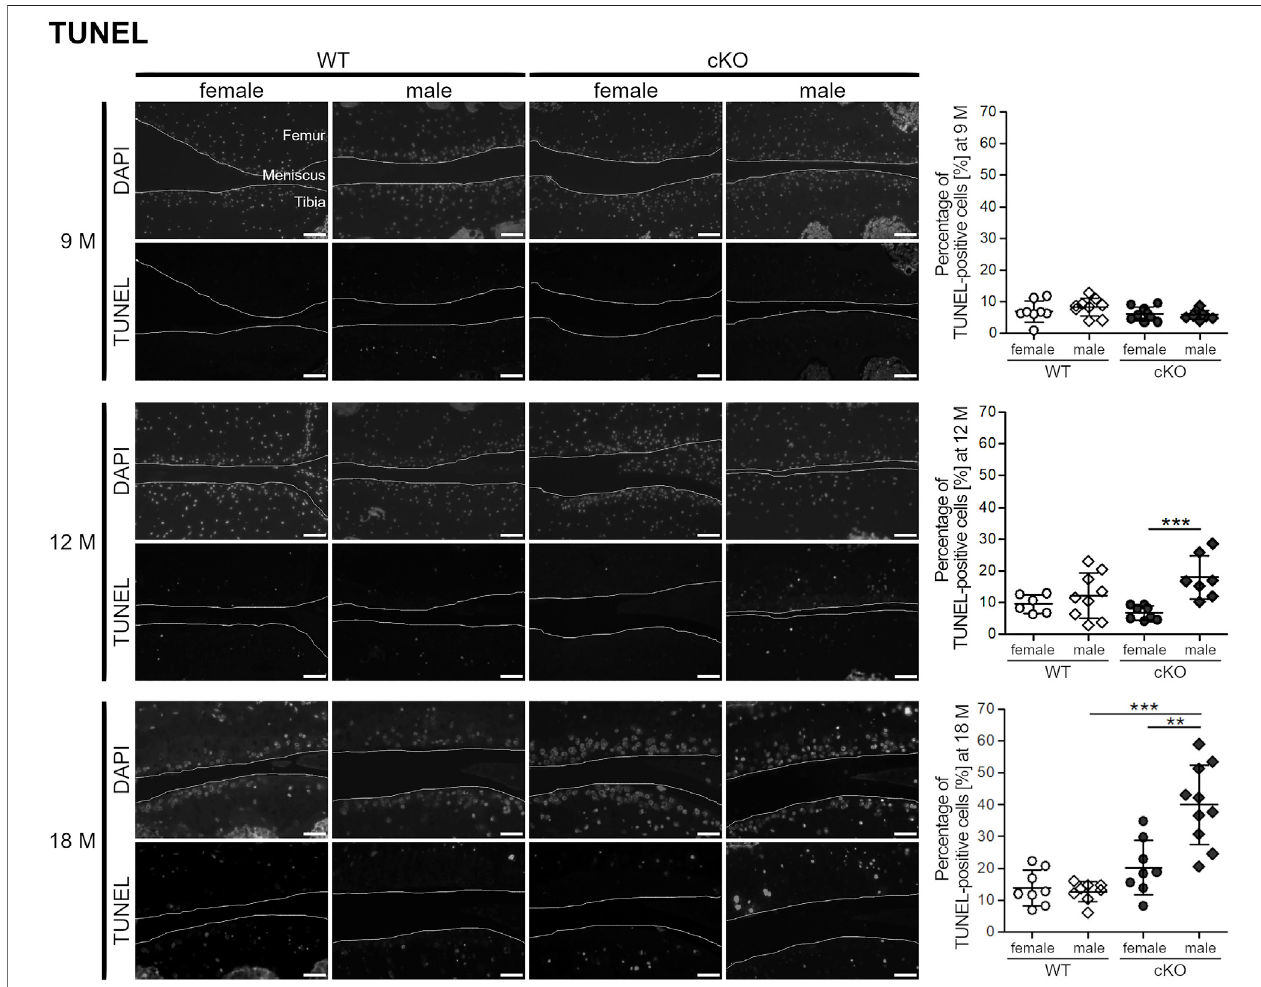
FIGURE 4 | Female mice develop less apoptotic cells during ageing compared to male mice. TUNEL staining reveals a higher percentage of apoptotic cells in the knee sections of12 monthsold male ERp57 cKO mice, while female mice remain on alow level ( p = 0.00069). This difference is even increased at the age of 18 months ( p = 0.00161,699). Then, male cKO mice additionally have signi fi cantly higher numbers of apoptotic cells than male WT mice ( p = 0.00001840). Joint surfaces are highlighted. Scale bars = 50 μ m, M = months.